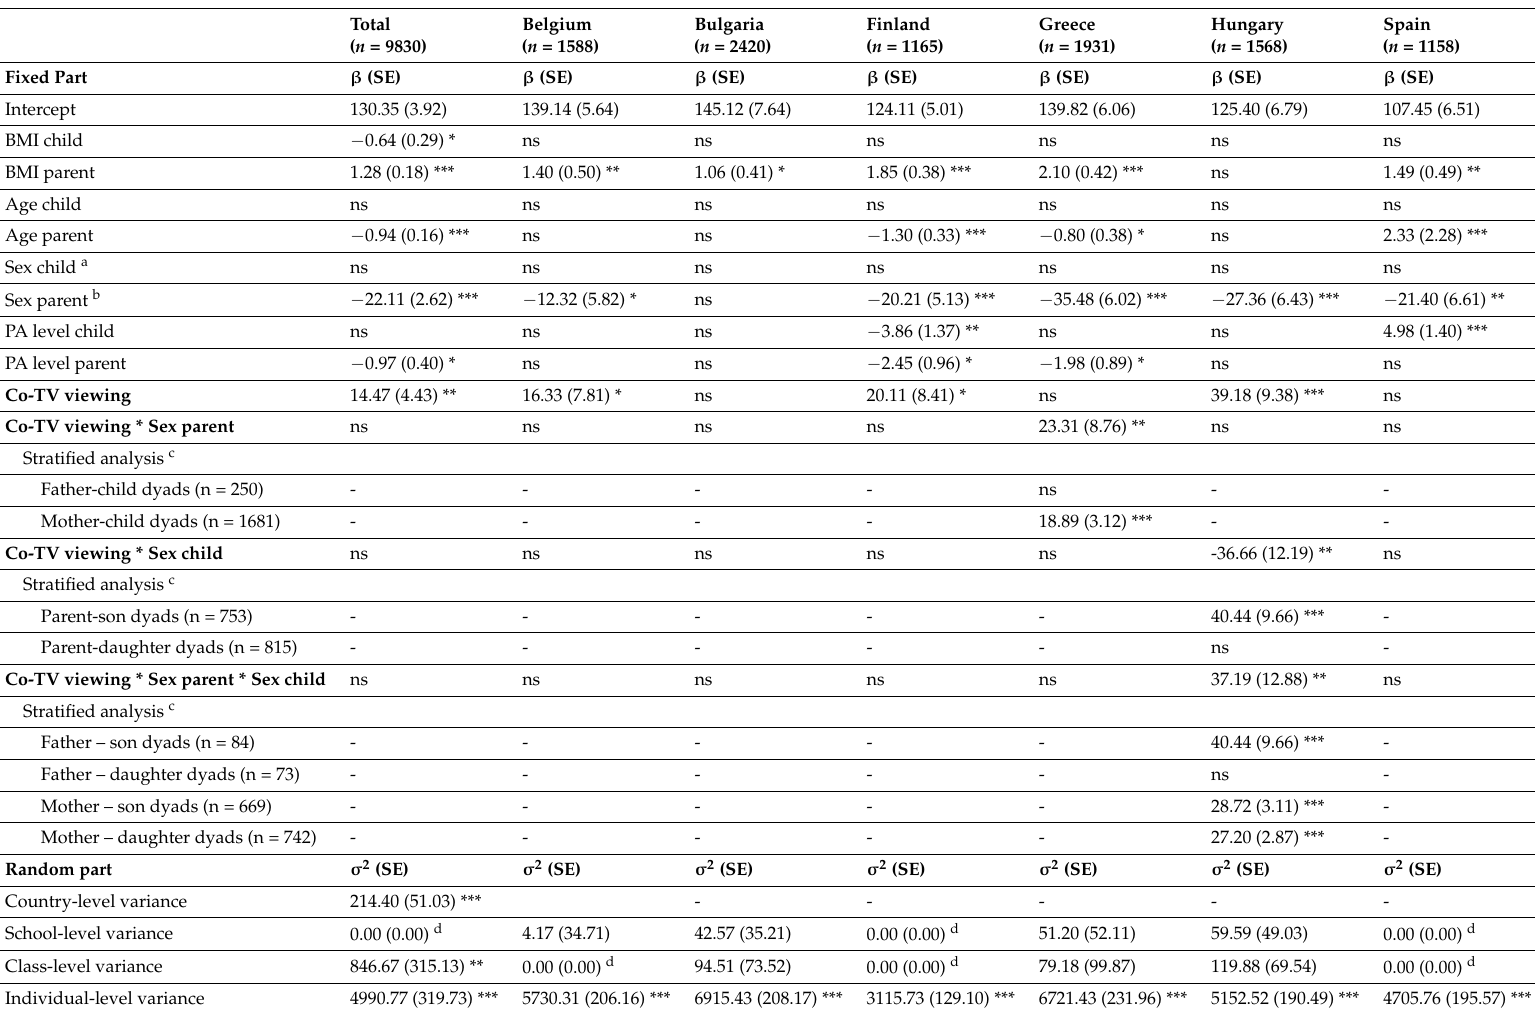
Table 3. Screen time of the parent. Results of multilevel model analyses on parents’ screen time (min/day) (full